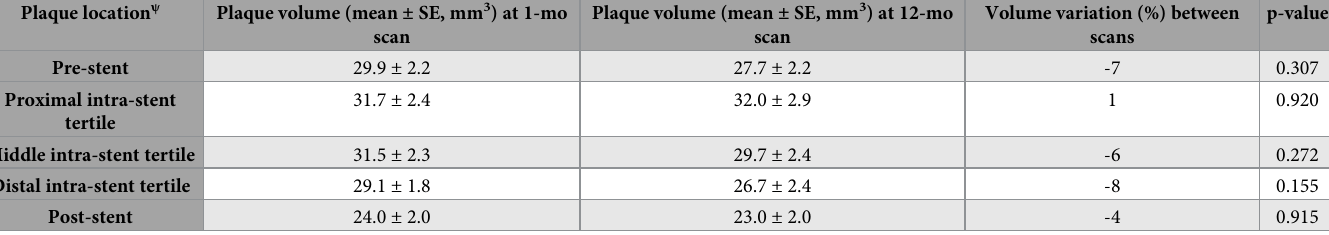
Table 7. Plaque volume at 1- and 12-month follow-ups by plaque location (pre-, 1 st , 2 nd , 3 rd intra-stent tertiles, and post-stent plaque). Plaque location